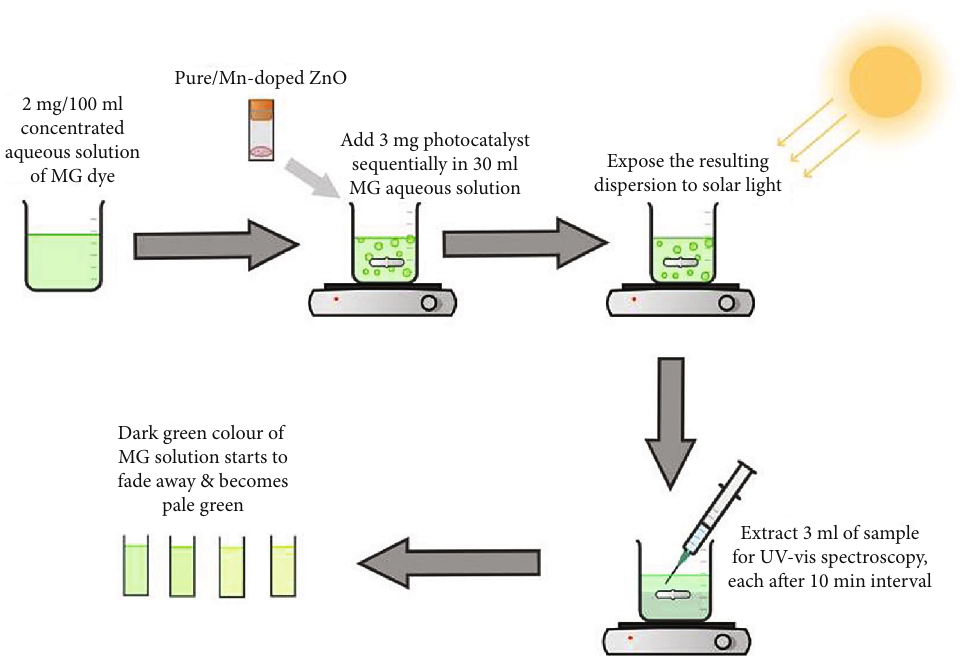
Figure 2: Photocatalytic activity of pure and Mn-doped ZnO towards methyl green (MG) dye, under natural sunlight